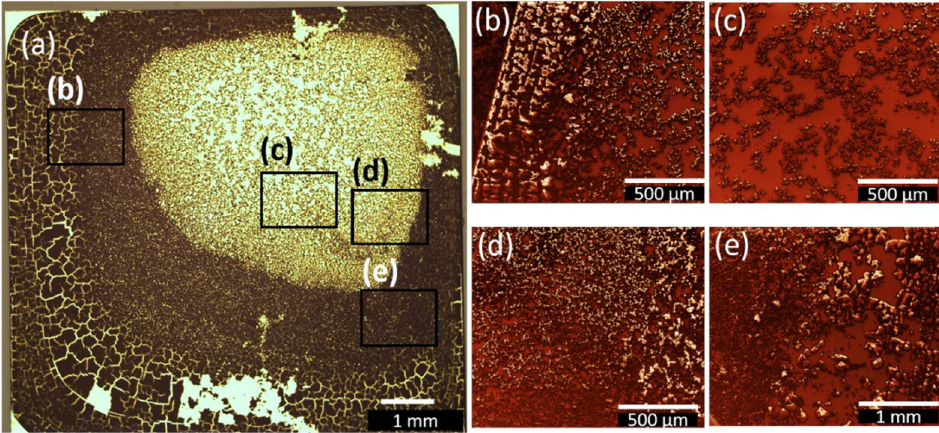
Figure 6. ( a ) Overview optical microscopy image for 2 –DrE–2 after the complete evaporation of ethanol. For better resolution SEM images with the same magnification were chosen in ( b – e ) at several spots of the sample, shown after applying image filter Gwyddion.net from Gwyddion software. The SEM images indicate island growth behaviour.